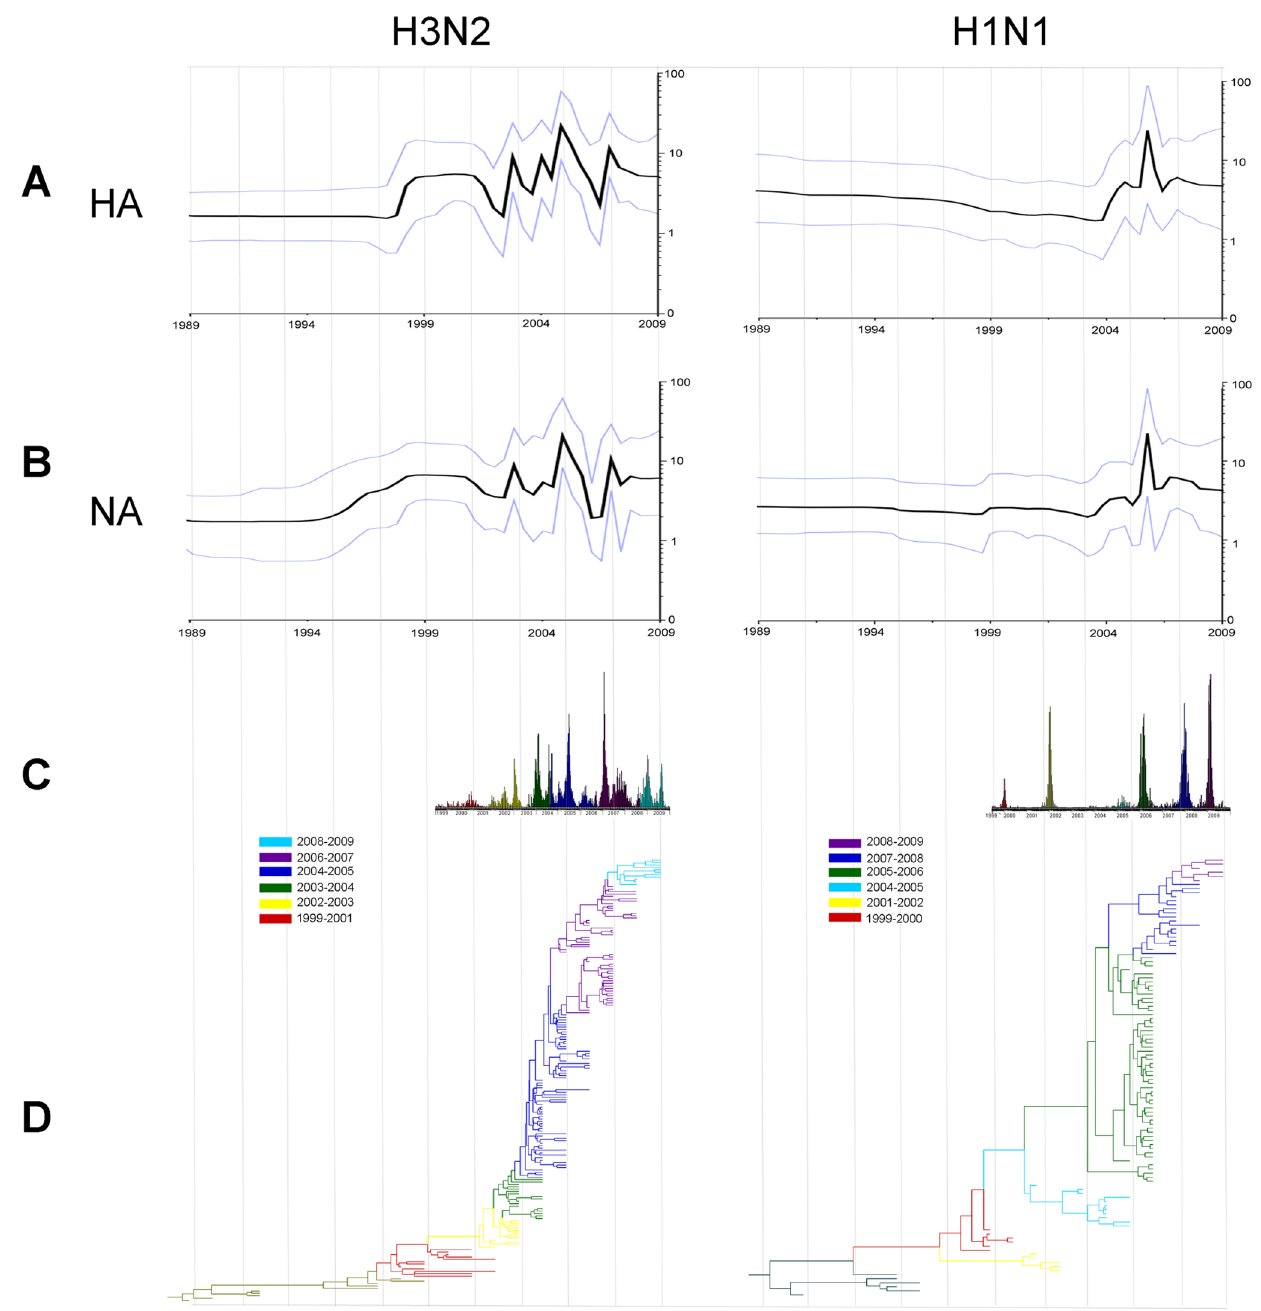
Figure 4. Phylodynamics of influenza viruses in Taiwan. H3N2 and H1N1 phylodynamic patterns are shown on left and right end panels, respectively. (A) Bayesian skyline plots based on HA and (B) NA sequence data. The Y-axis represents a measure of relative genetic diversity and reflects the number of effective infections established by the virus. The black line is the median posterior value; the gray lines represent the 95% HPD intervals. (C) Surveillance of influenza activity in Taiwan. The different variants detected in the epidemics are represented by the same colors used in the MCC trees below. (D) MCC trees of the HA segment. Different seasons are represented in different colors, according to the legend in the figure. Trees are scaled in units of time with tips constrained to strain sampling dates. evolved with the rise in gene complexity to generate multiple gene products, which might affect the immunogenicity of influenza virus due to the interactions of different mutations across different gene segments. The analysis demonstrated that the co-evolution of amino acids was not limited to intra- segment changes but also occurred at an inter-segment level.